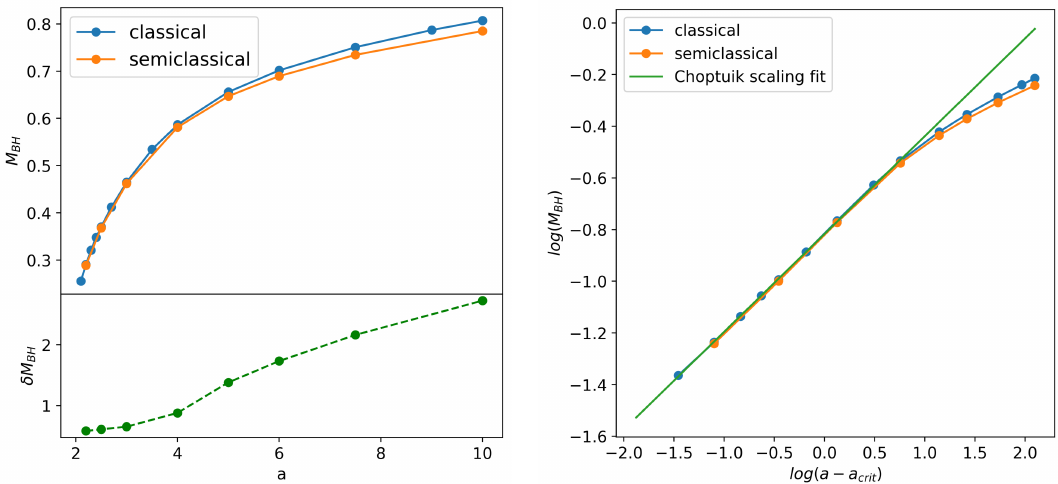
Figure 5 . Black hole mass M BH against initial amplitude a for both classical and semiclassical cases. In the left graph, both the M BH and a axis are linear, whereas in the right graph they are plotted (natural) logarithmically to illustrate the proportionality. In addition, the bottom part of the left graph shows the deviation of the semiclassical black hole masses from the classical black hole masses, in percentages. As the system is tuned closer to the critical point, the deviation